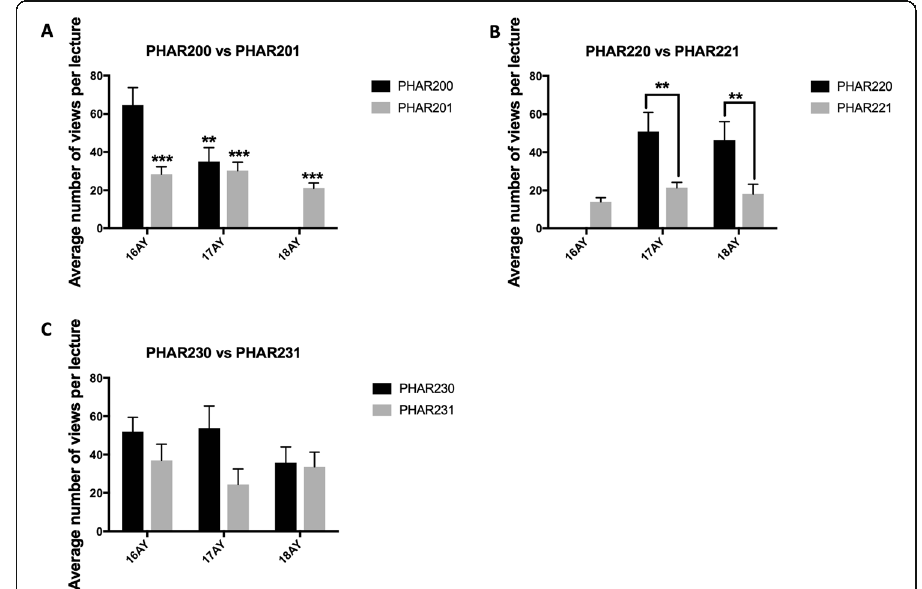
Fig. 1 Comparison of Fall and Spring semester courses delivered in series in Professional Year 1 over three academic years (16AY, 17AY and 18AY). Black bars indicate courses delivered in Fall and grey bars indicate courses delivered in Spring semesters. The bar charts represent the average number of views per lecture expressed as mean ± SEM. ** P < 0.01, *** P < 0.001 versus PHAR200 (16AY) (panel a ) or versus indicated groups (panel b